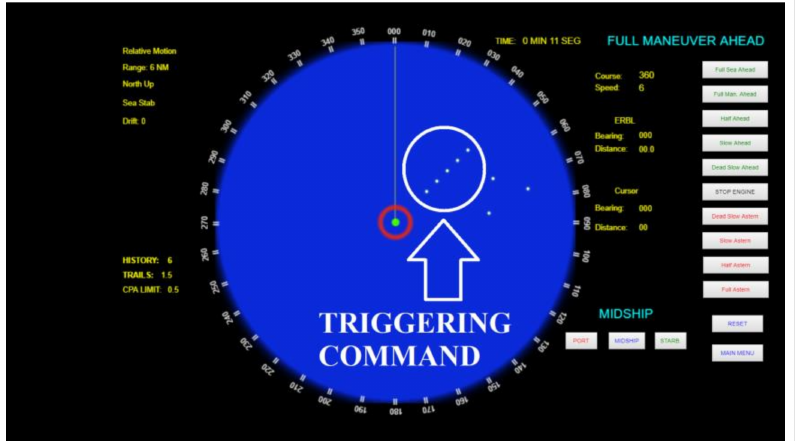
Figure 3. Representation of radar PPI screen with a triggering command (set of false echoes received due to an EA).